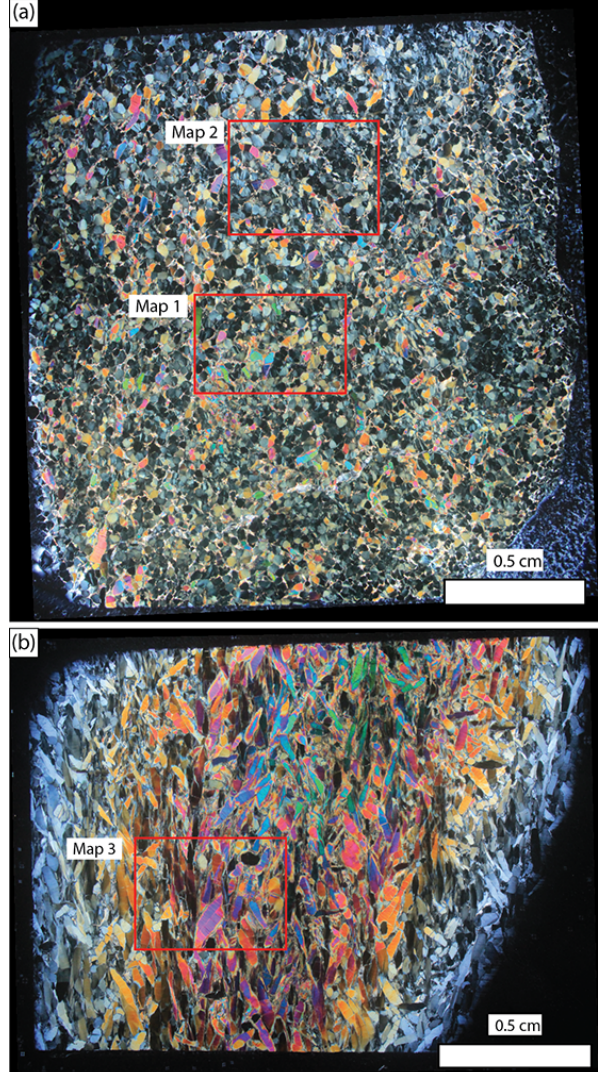
Figure 1. Crossed-polarised light photomontages of samples of Monte Fico lizardite vein (thin section thickness of ∼ 70µm). (a) Thin section MF01 ⊥ cut approximately perpendicular to the elongation direction of lizardite grains showing locations of maps 1 and 2 in Figs. 3 and 4. (b) Thin section MF01 (cid:107) cut approximately parallel to the elongation direction of lizardite showing location of map 3 in Fig.